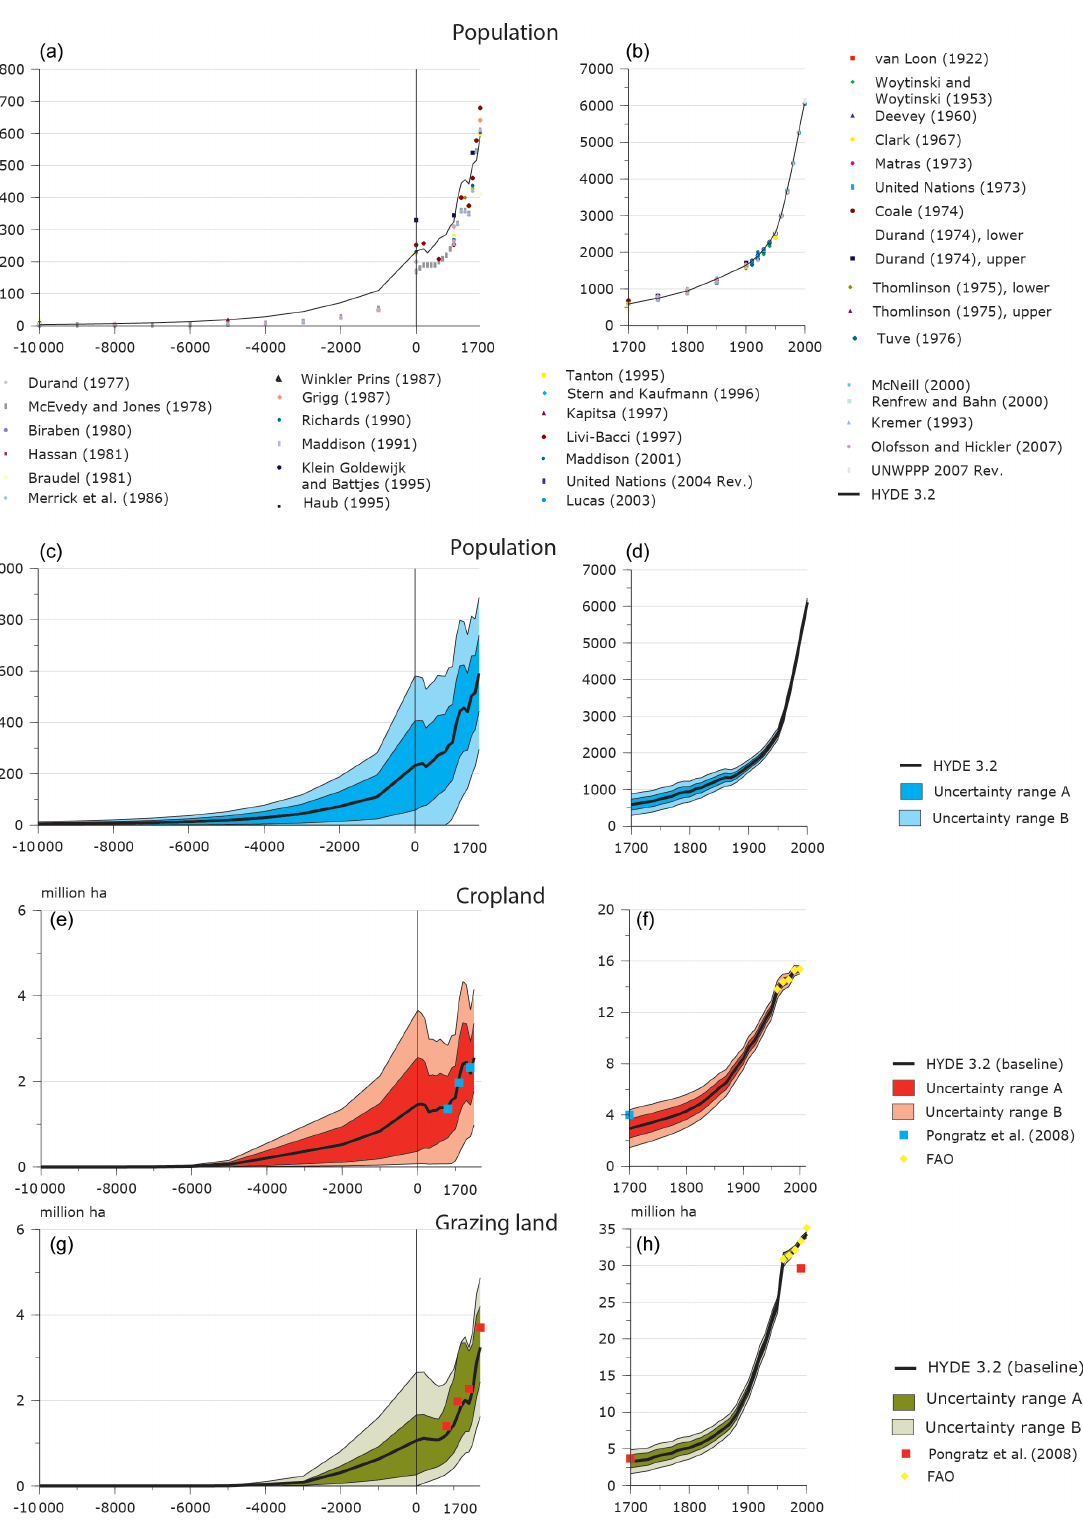
Earth Syst. Sci. Data, 9, 927–953, 2017